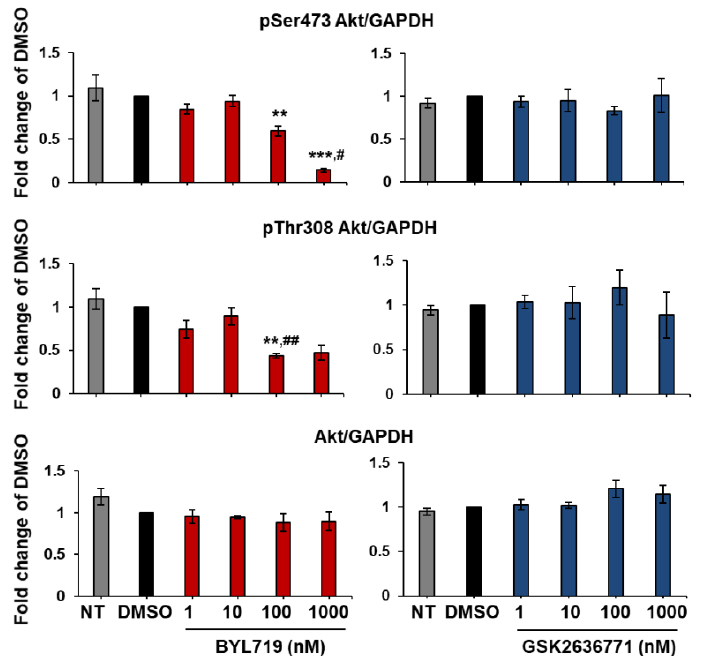
Figure 12. BYL719 inhibits Akt phosphorylation in IC8 cells in a dose-dependent manner. IC8 cells were left untreated (NT) or treated for 1 h with increasing concentrations of BYL719 and GSK2636771 in complete medium supplemented with 10% FBS. Control cells were treated with DMSO. Phosphorylation status and total levels of Akt were analyzed by Western blotting. GAPDH was used as loading control. Signals were visualized using Chemidoc™ MP Imaging System. Graphs show results from densitometry analysis of phosphorylated or total Akt normalized to loading control and expressed as fold change of results from DMSO-treated cells. Only blots showing clearly detectable bands were used for densitometry analysis. Data are means ± SEM from the following numbers of independent experiments: pSer473 Akt, n = 4 (apart from NT in BYL719 graph and from BYL719 1 nM, BYL719 10 nM and GSK2636771 100 nM, n = 3); pThr308 Akt, n = 4 (apart from